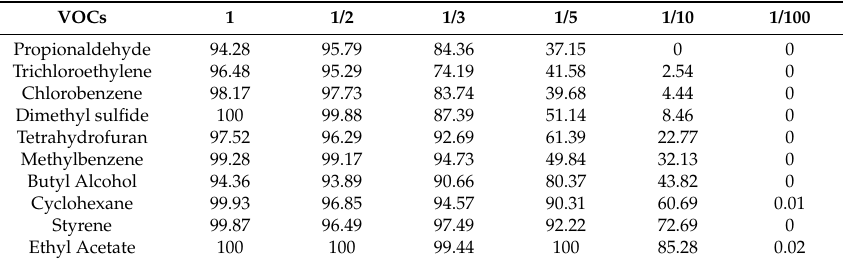
Table 3. Luminescent inhibition ratio (LIR) (%) at different dilution rates for VOC off-gas absorption solutions.